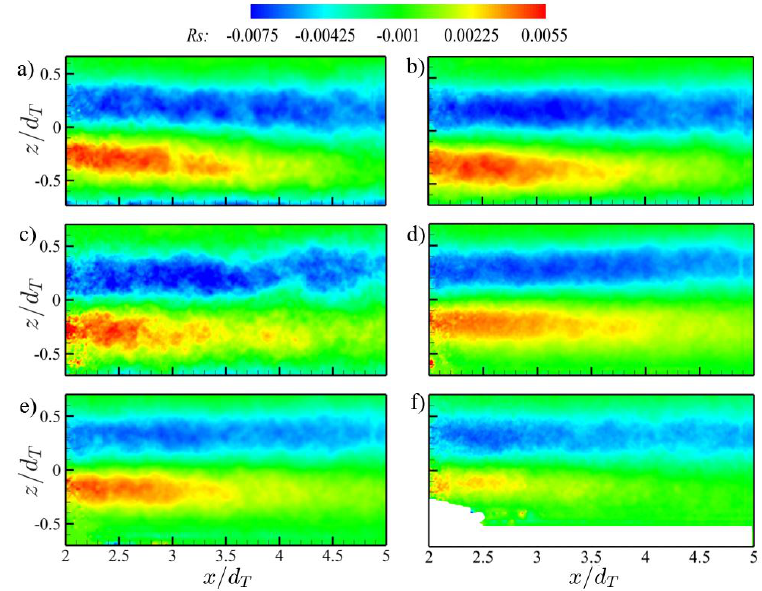
Figure 6. Kinematic shear stress distribution, − u (cid:48) w (cid:48) / U 2 and forward-facing step cases and flat terrain with ∆ z 0 / d T equal to: ( a ) − 0.64; ( b ) − 0.42; ( c ) − 0.21; ( d ) 0; ( e ) 0.21; and ( f )